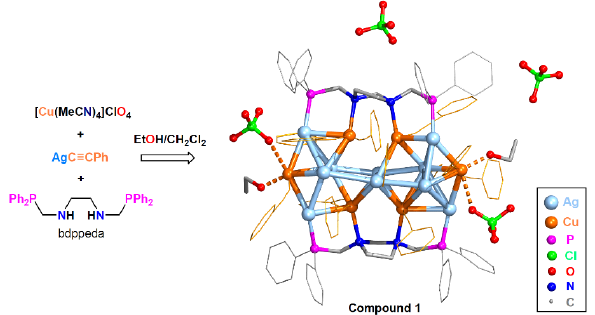
Figure 1. Synthesis and structure of 1 . The phenyl rings of -PPh 2 groups and C ≡ CPh groups are plotted as gray and yellow hexagons. CH 2 Cl 2 solvent molecules are omitted for clarity.